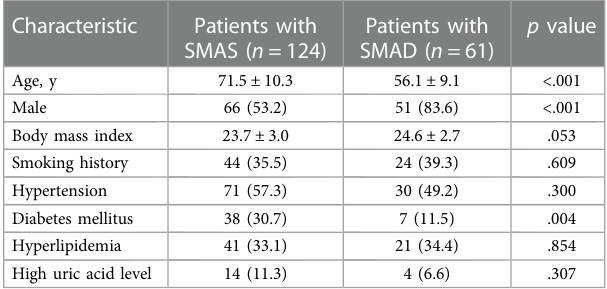
TABLE 1 Clinical characteristics of study patients.